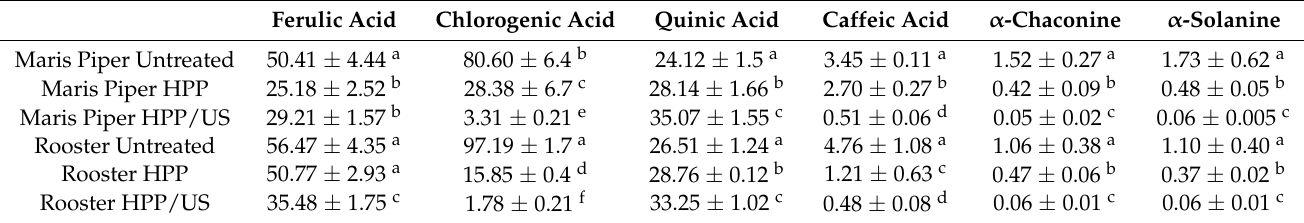
Table 2. Phytochemical content ( µ g/g dry weight) in untreated, HPP- and HPP/US-treated minimally processed potatoes. Ferulic Acid Chlorogenic Acid Quinic